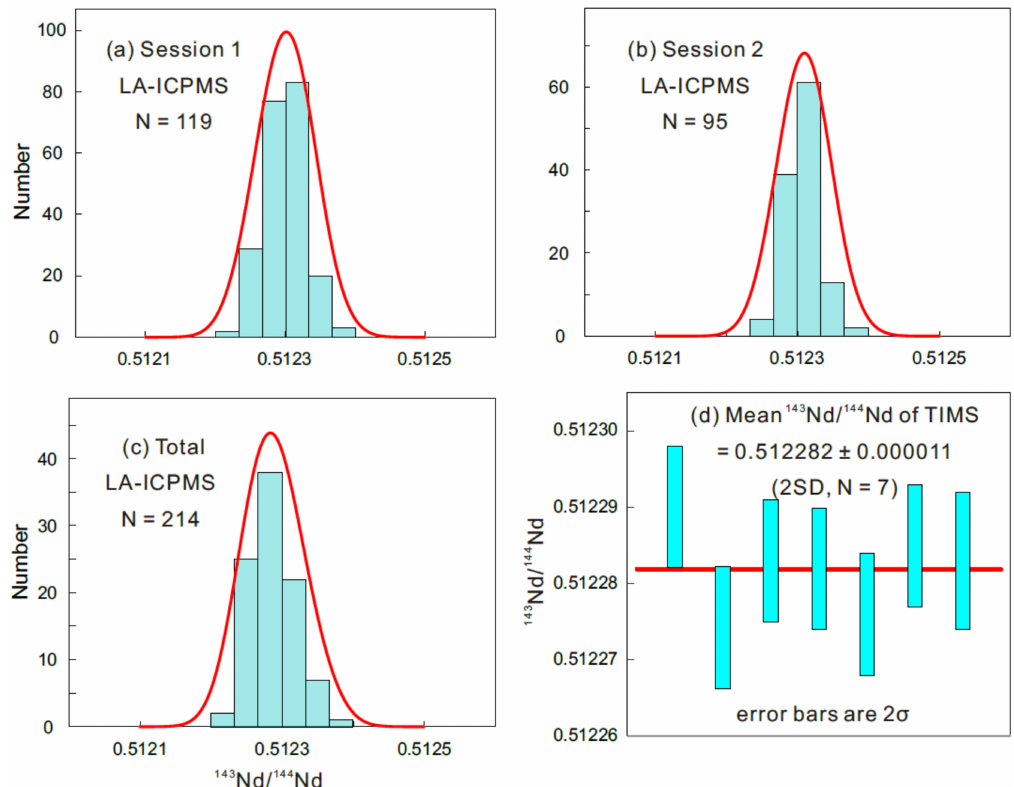
Figure 7. ( a – c ) Frequency distributions of RW-1 143 Nd / 144 Nd ratios determined by LA-ICPMS. ( d ) Range of 143 Nd / 144 Nd values determined by thermal ionization mass spectrometry (TIMS). Seven TIMS Nd isotopic analyses yielded 143 Nd / 144 Nd ratios of 0.512274 ± 0.000008 to 0.512290 ± 0.000008 (Table S4), with a mean of 0.512282 ± 0.000011 (2SD; Figure 7d), identical, within